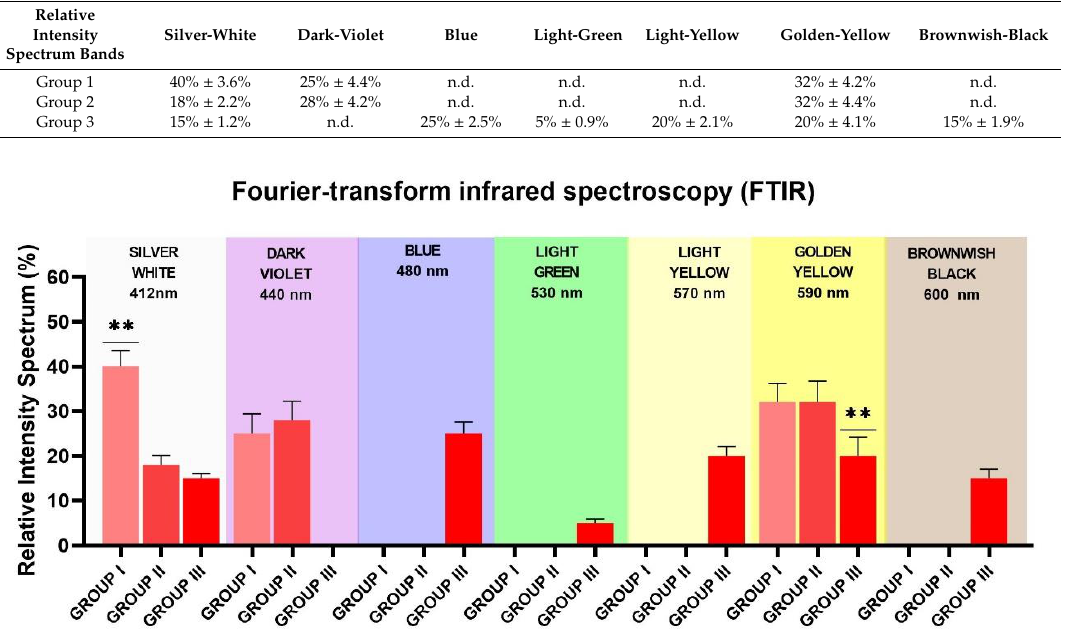
Figure 4. ( A ) The samples after laser irradiation at 1 W, and ( B ) after laser irradiation at 4 W. The untreated area and treated area show a different color distribution. Table 2. Fourier-transform infrared spectroscopy (FTIR) evaluation of the grade 4 titanium disks’ surface: relative intensity spectrum bands of the study groups (mean, standard deviation). n.d. = not detectable.